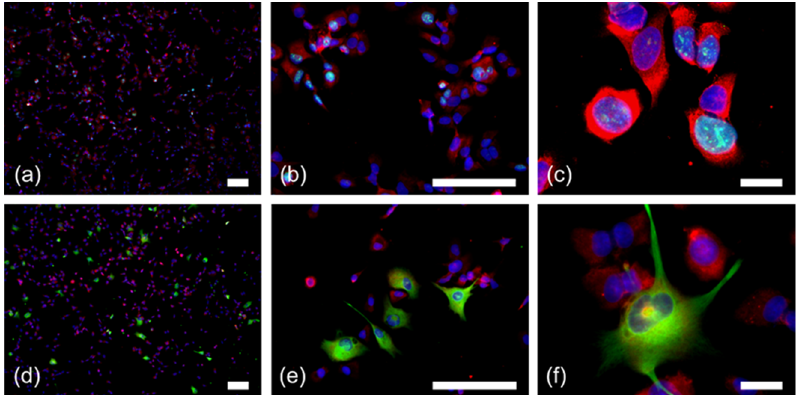
Figure 4. RPS27 staining in conjunction with Ki67 and GFAP positivity in GBM stem-like cells. ( a – c ) Immunofluorescence double staining for RPS27 (red) and Ki67 (green). ( d – f ) Immunofluorescence double staining for RPS27 (red) and GFAP (green). DAPI = blue, scale bars in ( c ) and ( f ) = 20 µm, otherwise scale bars = 100 µm. For the single color channels see Figure S2.